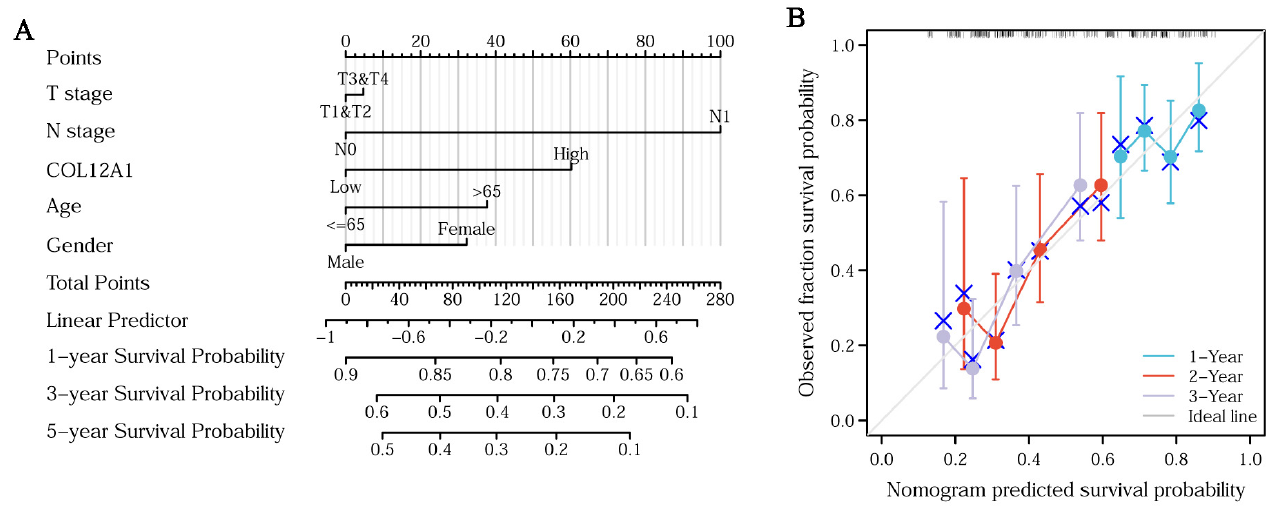
Figure 6. Nomogram analysis for pancreatic cancer over survival. ( A ) The nomogram analysis involving COL12A1 expression, age, gender, and the T and N stages to predict the prognosis in pancreatic cancer patients. ( B ) Predicted survival ability of this nomogram for 1, 2, and 3